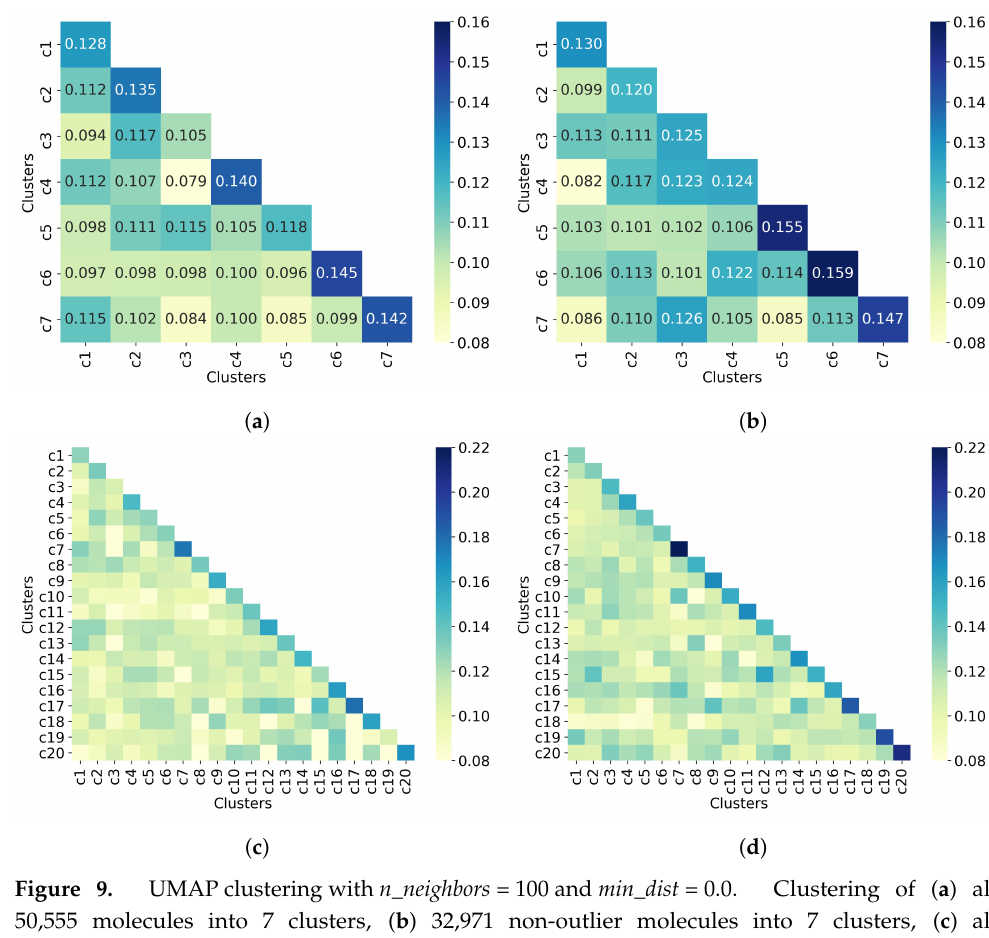
Figure 9. UMAP clustering with n_neighbors = 100 and min_dist = 0.0. Clustering of ( a ) all 50,555 molecules into 7 clusters, ( b ) 32,971 non-outlier molecules into 7 clusters, ( c ) all 50,555 molecules into 20 clusters, and ( d ) 32,971 non-outlier molecules into 20 clusters. Outlier molecules were removed using an outlier cutoff of 0.5 (see Section 3.1 for more details about outlier detection). The matrix is calculated as the average Tanimoto similarity between the molecules of cluster i and those in cluster j , and the average similarity between molecules of a cluster and itself (see Section 2.3 for more details on how this matrix is calculated). The matrices have been adjusted to the same scale to facilitate clustering comparison between all molecules and non-outlier molecules.